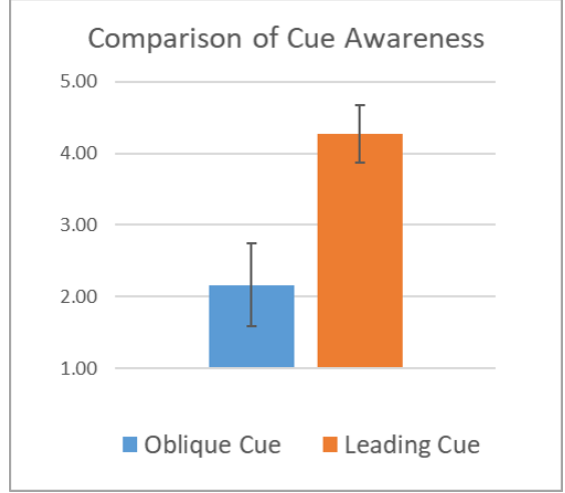
Figure 5. Comparison of cue awareness.